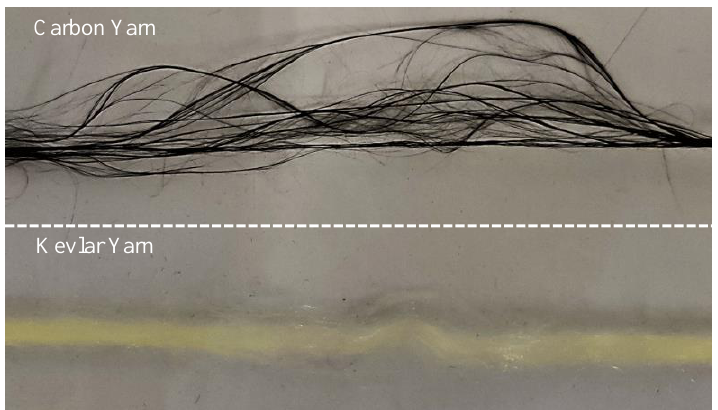
Figure 8. Failure modes of two different yarns.